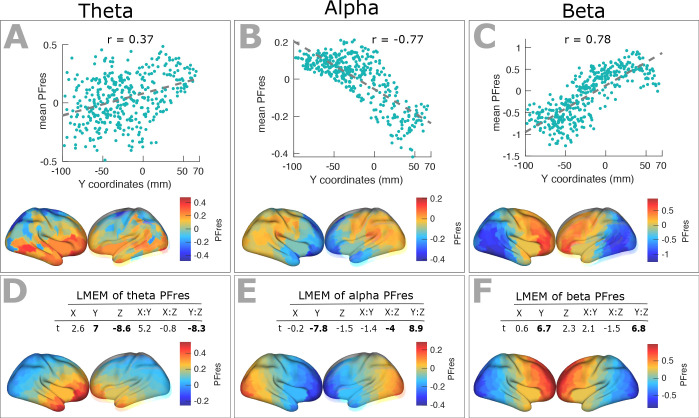
Spatial gradients of band-specific PF across the cortex after factoring out the impact of 1/f components (offset and slope).(A) Top panel: Scatter plots representing the relationship between trimmed mean PFres (187 participants, 384 ROIs) and ROI’s location along the y-axis for theta band (r = 0.3, p<0.001), together with corresponding cortical map of trimmed mean PFres.Panels (B) and (C) show the same results for alpha (r = −0.77, p<<0.001), and beta (r = 0.78, p<<0.001) frequency ranges. The residual PF scores (PFres) were obtained after regressing out the contribution of 1/f offset and slope values (fixed effect) from band-specific PF, using LMEM. (D) Top panel: t-values obtained from linear mixed effect modeling of band-specific PFres as a function of the coordinates of the ROI centroids for theta band (LMEM; t-values: Y = 7, Z = −8.6, Y:Z = −8.3; all p<0.001). Bottom panel: cortical map of the corresponding fixed effect parameters (see Equation 2 for details). Similarly, panels (E) and (F) show the results for alpha (LMEM; t-values: Y = −7.8, X:Z = −4, Y:Z = 8.9; all p<0.001), and beta (LMEM; t-values: Y = 6.7, Y:Z = 6.8; all p<0.001) frequency ranges, respectively. These analyses demonstrate that the spatial gradient of band-specific PFs is independent of spatial changes of 1/f slope and offset.